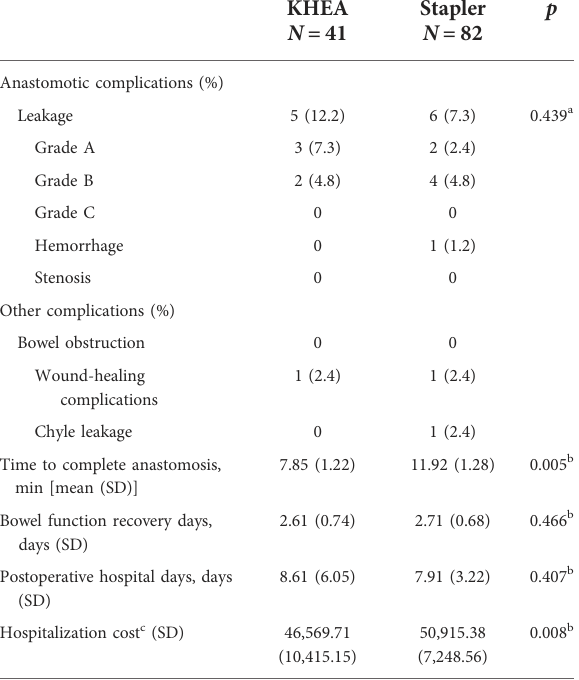
TABLE 2 Comparison of short-term outcomes and costs. KHEA Stapler p N = 41 N = 82 Anastomotic complications